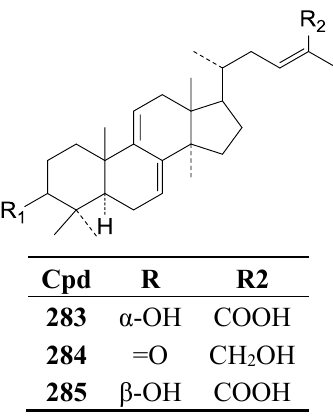
Figure 33. Structures of compounds 283 – 285 .